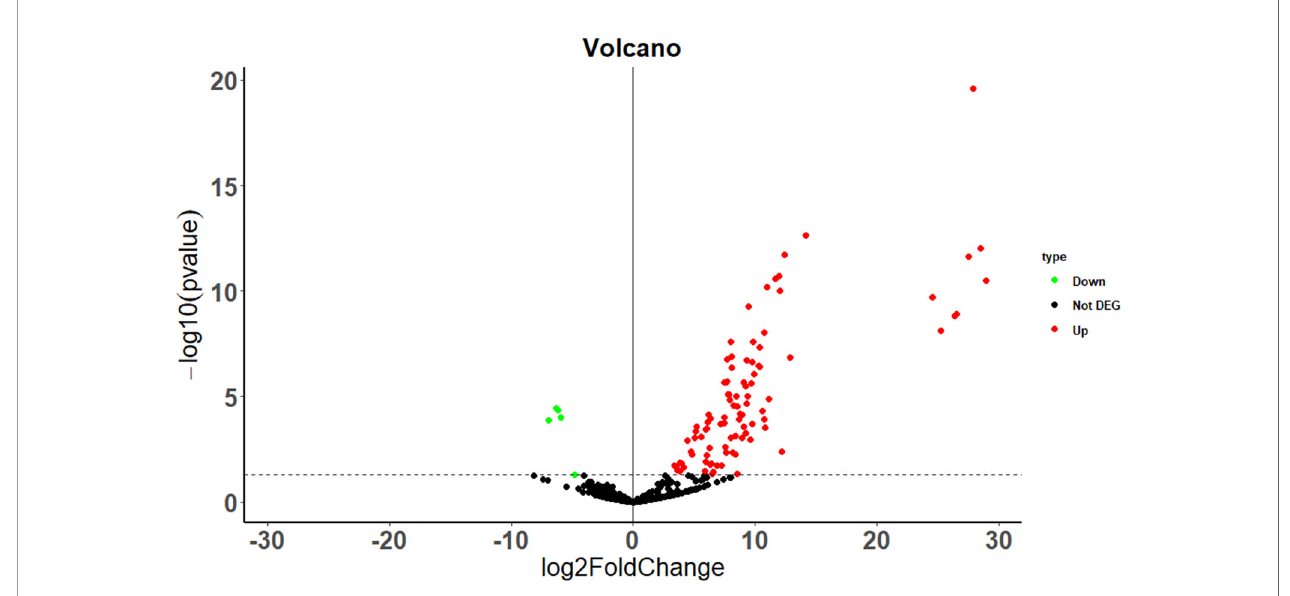
FIGURE 1 | Differential gene volcano map between the case and the control group. The dotted line indicates p =